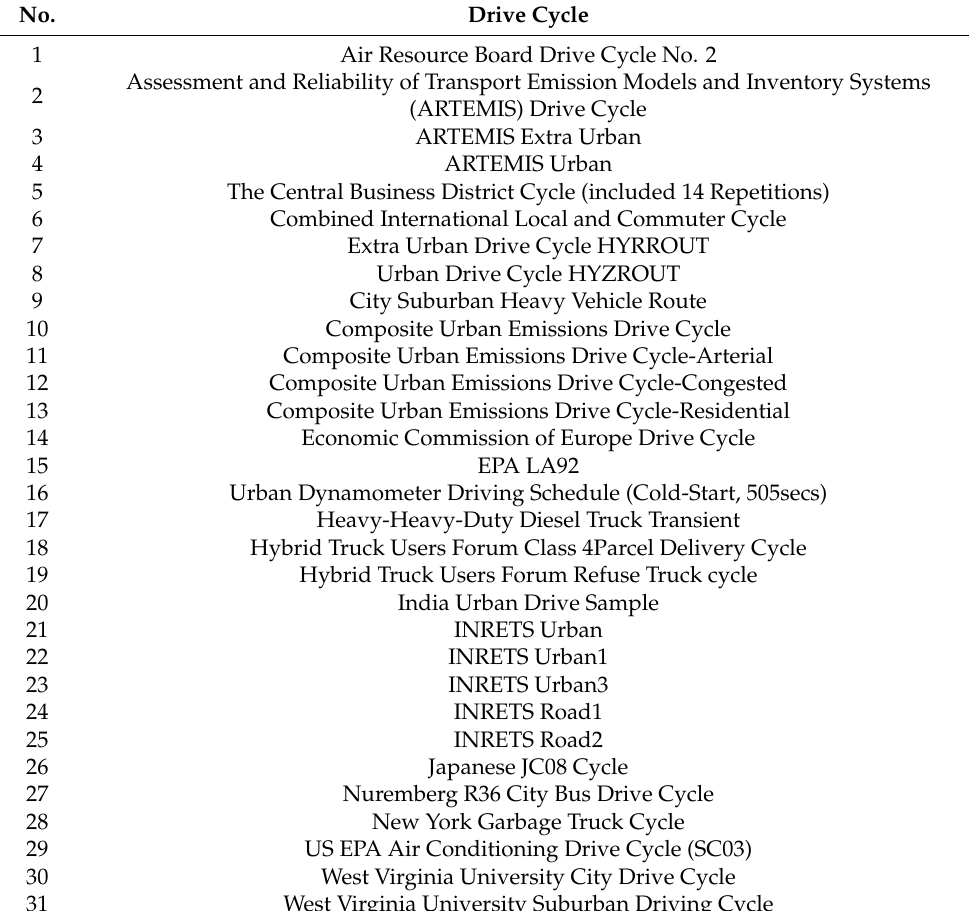
Table A1. Training set.